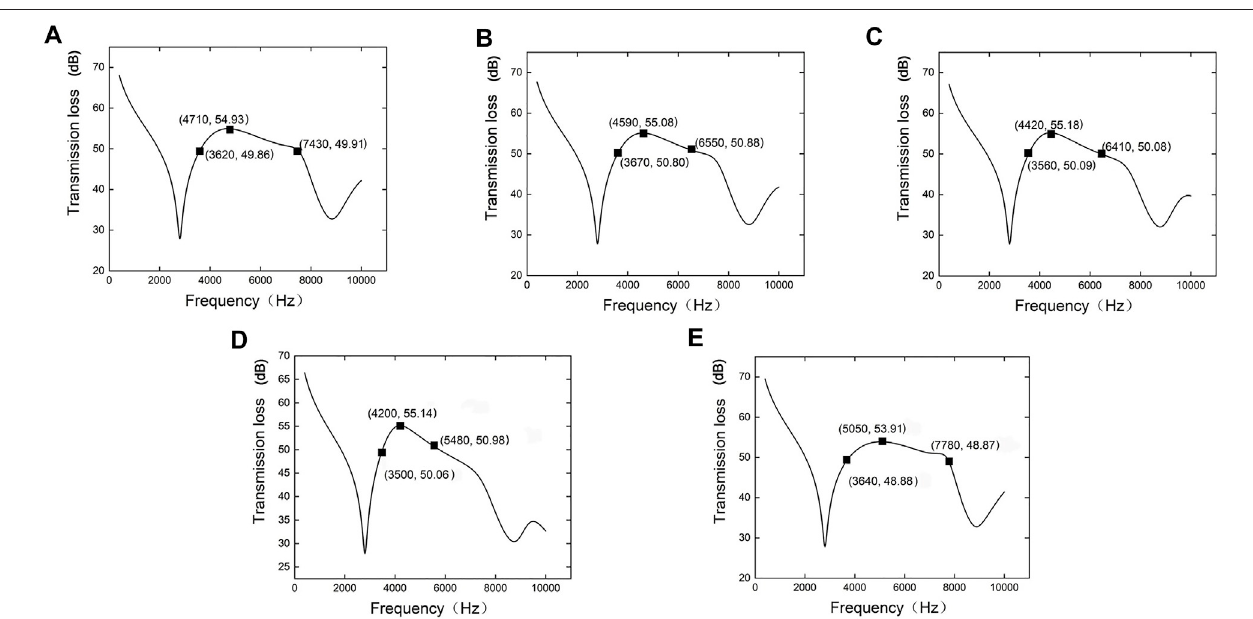
FIGURE 6 | Performance curvesfor sound insulation ofthe three- fi lm system for which the Young ’ s moduli ofthe fi lms ① , ② , and ③ are: (A) 2 MPa, 14 MPa, and 28 MPa, (B) 2 MPa, 12 MPa, and 24 MPa; (C) 2 MPa, 10 MPa, and 20 MPa; (D) 2 MPa, 8 MPa, and16 MPa; and (E) 2 MPa, 30 and 60 MPa.